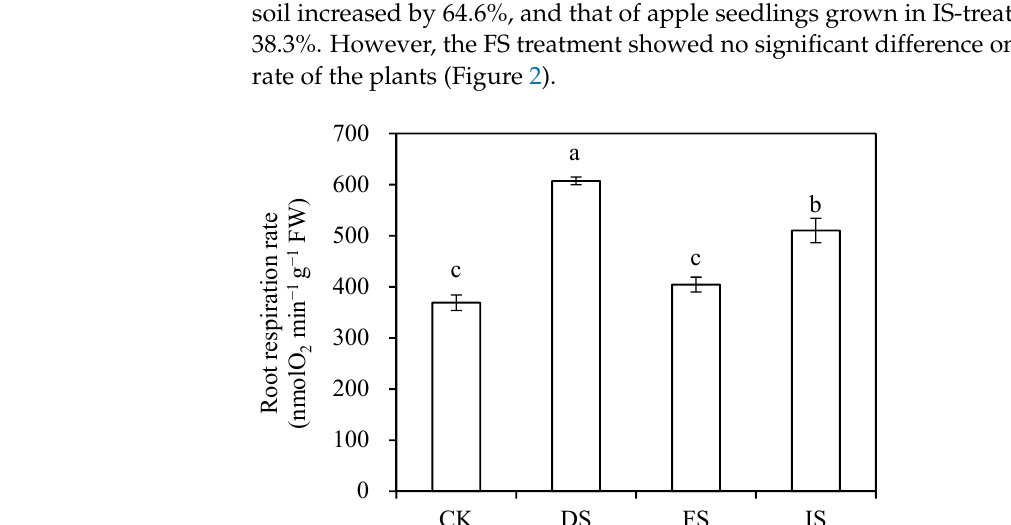
Figure 2. Effects of different forms of Tagetes erecta biofumigation on root respiration rate of M. hupehensis seedlings. CK: replanted soil, DS: air-dried T . erecta sample, FS: fresh T . erecta sample, IS: infusion solution of fresh T . erecta . Data are the means of three replicates, and the different letters over on the columns indicate significant differences at p < 0.05.